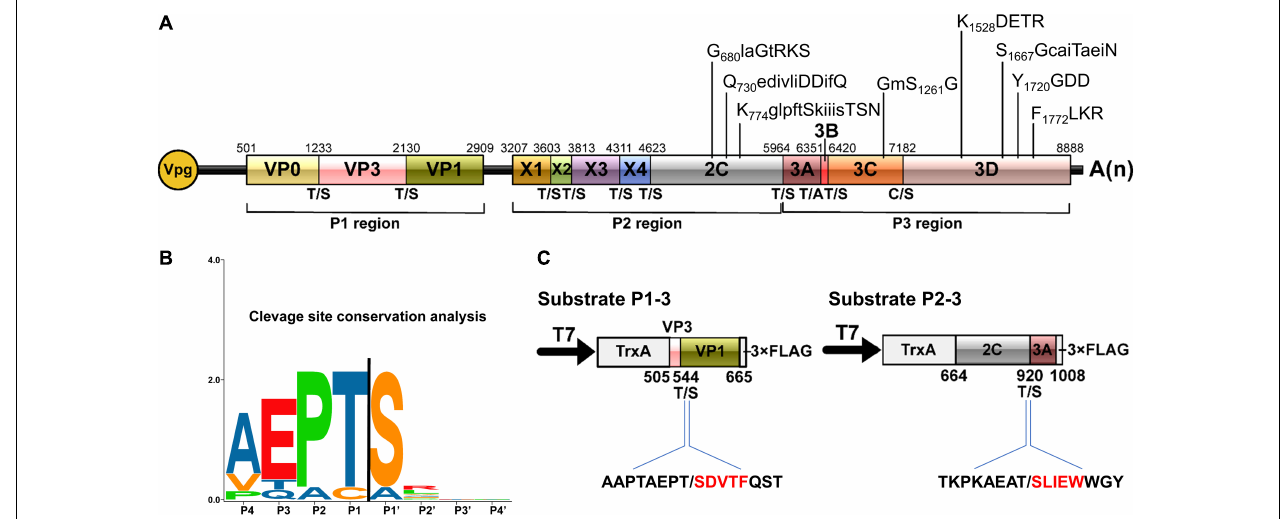
FIGURE 5 | Conservation analysis of cleavage sites in rice curl dwarf-associated picornavirus (RCDaV) polyproteins. (A) Schematic representation of the elaborate genome organization. The genome maps and each gene boxes were drawn to scale. Nucleotide position of individual protein is indicated above each gene box. The structural proteins are named as reported previously (Roberts and Groppelli, 2009). The cleavage sites are indicated at the borders between the two cleaved proteins. The conserved picornaviral motifs are indicated above the diagram. (B) Sequence logos of RCDaV cleavage sites. The P4–P1/the P1 (cid:48) –P4 (cid:48) aa of cleavage sites are shown. Amino acids are color-coded according to their physicochemical characteristics. Neutral and polar, green; basic, blue; acidic, red; neutral and hydrophobic, black. Amino acids are shown as one-letter standard code. (C) The first five amino acids (red) in cleavage products of substrates P1-3 and P2-3 were determined through N-terminal Edman degradation sequencing. Slashes indicate the cleavage